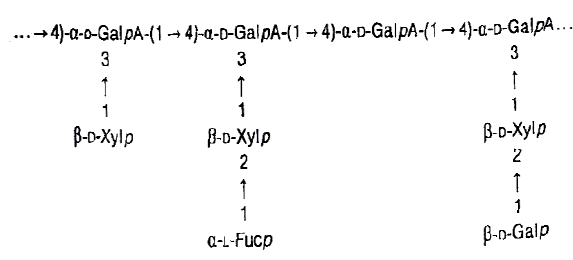
Figure1. Structure of gum tragacanth Purification, grafting, hydrolysis and are useful methods for increasing effectiveness of natural flocculants.